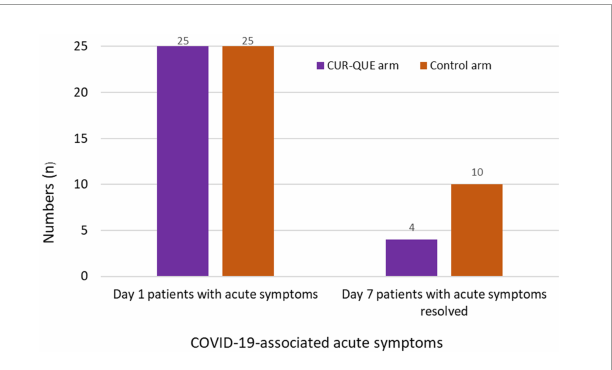
FIGURE3 Patient’s COVID-19-associated symptoms at day 1 and follow-up day 7 in the two treatment